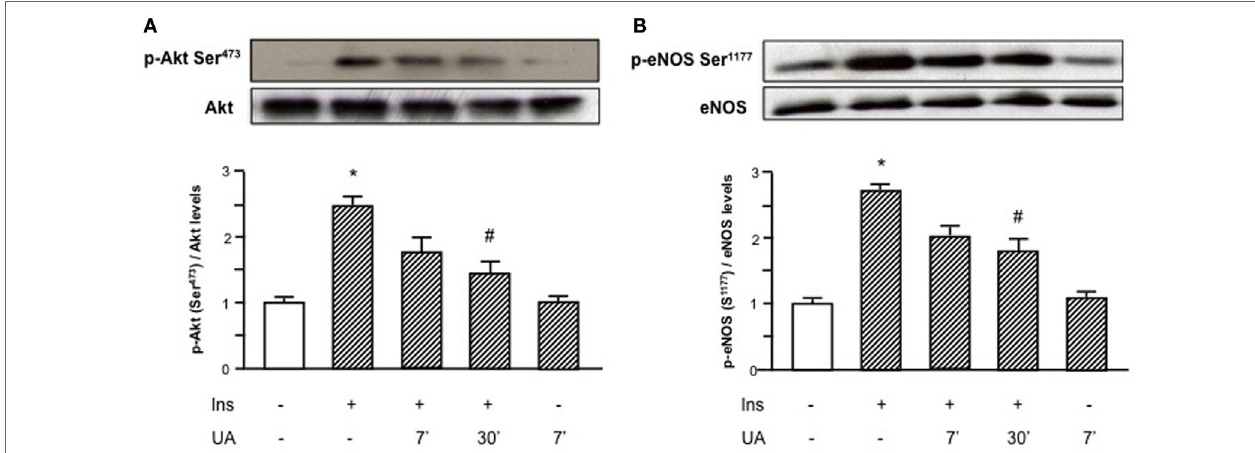
FigUre 1 | Effects of uric acid (UA) on insulin-induced Akt (a) and endothelial nitric oxide synthase (eNOS) (B) phosphorylation at Ser 473 and Ser 1177 , respectively. Exposure of human umbilical vein endothelial cells to insulin induces a rapid activation of Akt/eNOS axis; in presence of UA this effect is largely reduced, particularly at 30 ′ . To normalize the blots for protein levels, after being immunoblotted with anti-phosphospecific antibodies, the blots were stripped and reprobed with anti-Akt or anti-eNOS total forms. Bars represent means ± SE, expressed as relative change in comparison with the basal value, for three independent experiments and autoradiographs of a representative experiment are shown. * P < 0.05 vs basal value; # P < 0.05 vs